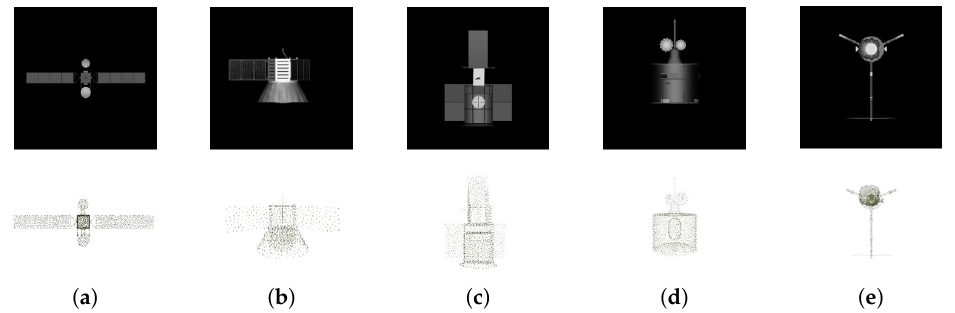
Figure 5. Simulated satellite images and corresponding point cloud. ( a ) A2100; ( b ) COBE; ( c ) EARLY- BIRD; ( d ) DSP; ( e )